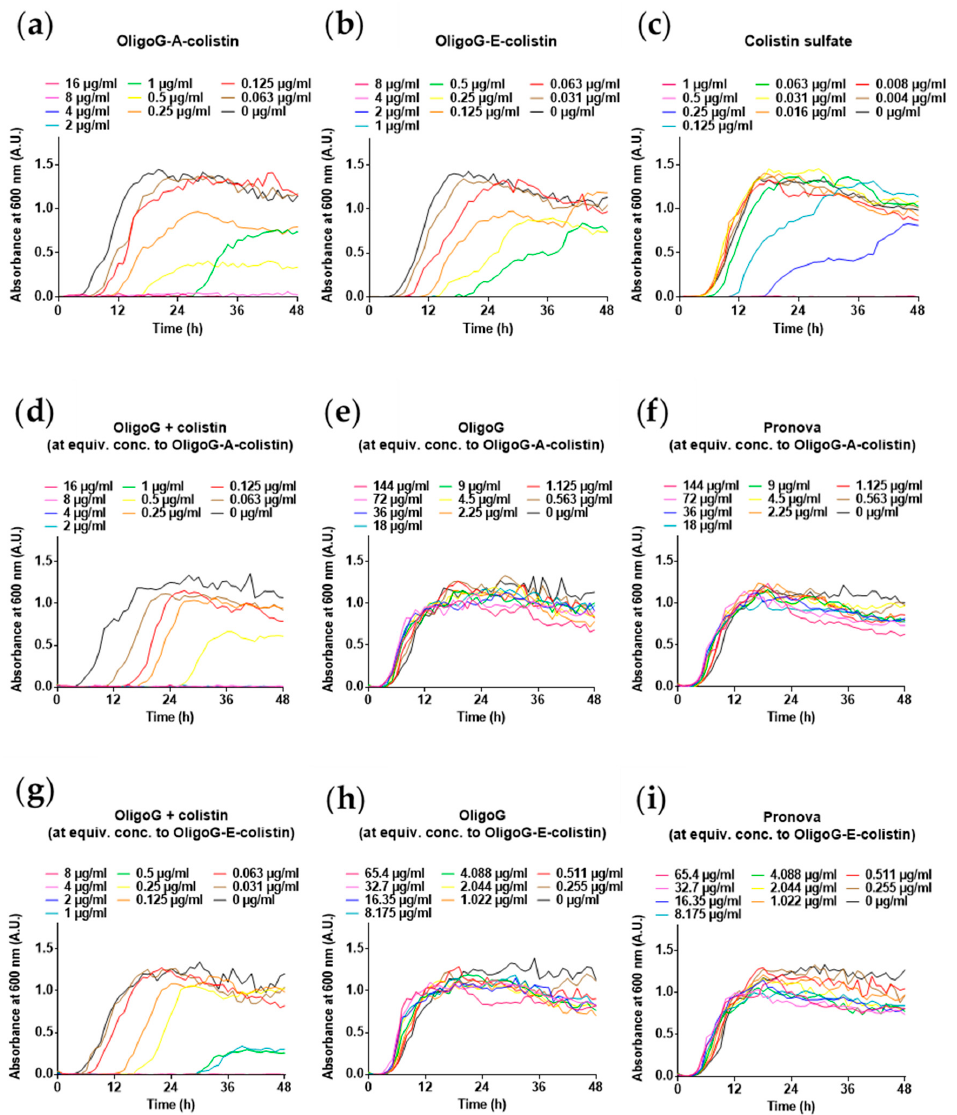
Figure 2. Bacterial growth curves for P. aeruginosa MDR 301 (48 h) in the presence of the following antimicrobials. ( a ) OligoG–A–colistin conjugate. ( b ) OligoG–E–colistin conjugate. ( c ) Colistin sulphate. ( d ) Colistin sulphate plus OligoG control for amide-linked conjugate. ( e ) OligoG control for amide-linked conjugate. ( f ) PRONOVA control for amide-linked conjugate. ( g ) Colistin sulphate plus OligoG control for ester-linked conjugate. ( h ) OligoG control for ester-linked conjugate. ( i ) PRONOVA control for ester-linked conjugate. Controls were used at the equivalent concentrations used in the corresponding amide- or ester-linked conjugates ( n = 3). Abbreviations: A, amide; E, ester.